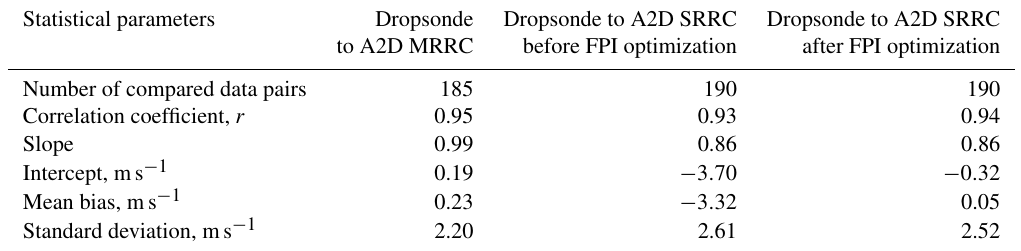
Fig. 12a have opposite trends at lower and higher heights, which is related to the intercept difference shown in Fig.